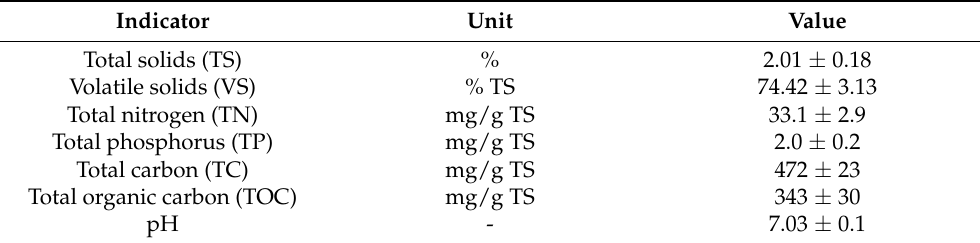
Table 2. Characteristics of anaerobic sludge used as the inoculum of anaerobic reactors.